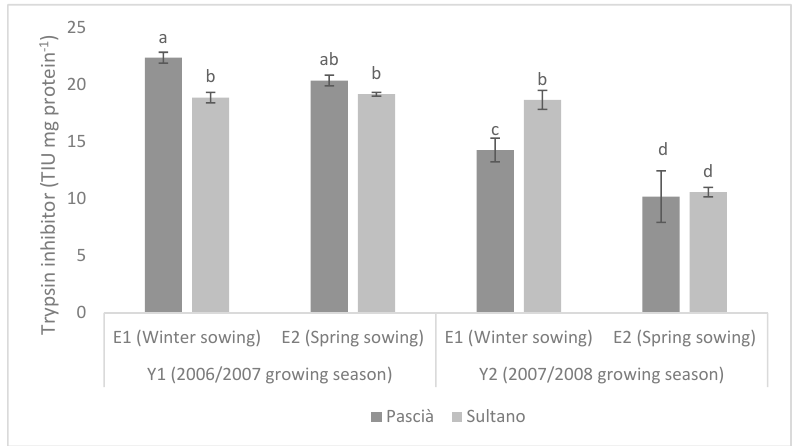
Figure 3. Content of Trypsin inhibitors in seeds (TIU mg protein ± SE) of the two varieties in the two growing seasons. Means with different letters are significantly different (Fisher’s LSD, p ≤ 0.05).